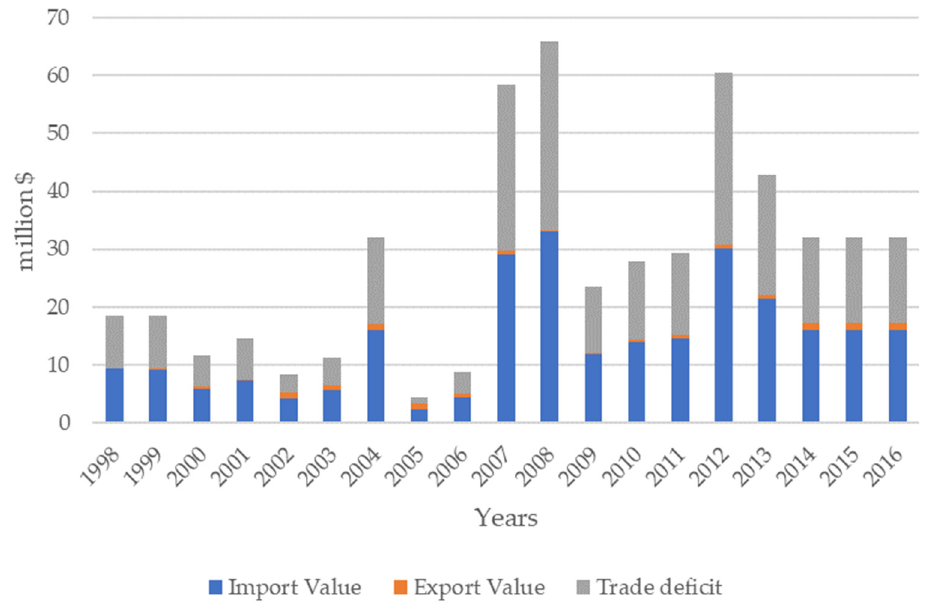
Figure 1. The trade balance and deficit for the Greek forest sector. Source: Authors’ own work, based on FAO data [https://www.fao.org/faostat/en/#home (accessed on 24 September 2022)].